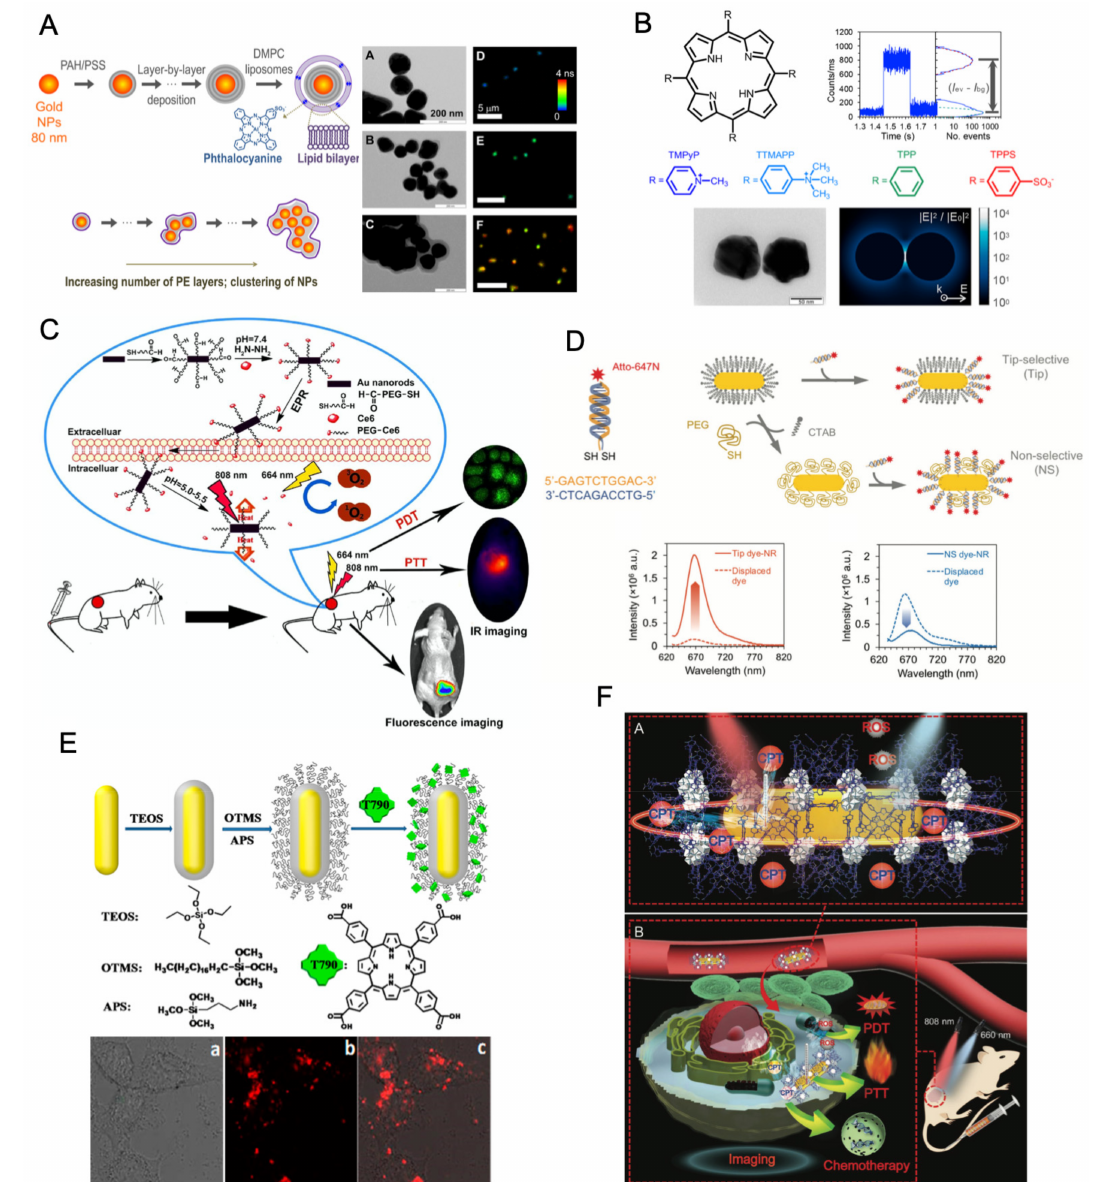
Figure 9. ( A ) Sequence of core-shell preparation of gold nanoparticles with a polyelectrolyte shell of PAH/PSS layers and an outer DMPC lipid bilayer embedding a phthalocyanine dye (top left). Gold nanoparticles form clusters as the number of polyelectrolyte layers is increased (bottom left). Electron microscopy (TEM) and fluorescence lifetime (FLIM) images of gold nanoparticles modified with a polyelectrolyte shell for an increasing number of PAH/PSS layers (5, 9, and 21 layers from the top down). Adapted with permission from [155]. Copyright 2015 American Chemical Society. ( B ) Chemical structure of the four porphyrins investigated for plasmon-enhanced fluorescence. Intensity time trace (top left) and example of an event of extreme fluorescence enhancement for TMPyP porphyrin (top right). TEM images of a dimer of gold nanoparticles obtained by DNA-directed assembly and near-field enhancement map calculated from discrete dipole approximation simulations. Adapted with permission from [156]. Copyright 2019 American Chemical Society. ( C ) Synthesis of core-shell hybrid gold nanorods Ce6-PEG-AuNR and their function for combined PTT/PDT [157]. © 2017 Elsevier B.V. All rights reserved. ( D ) Scheme of dye-labelled dsDNA oligonucleotide and preparation of dye-particle nano-assemblies using: (top) tip-selective thiol attachment toward the nanorod tips; (bottom) non-selective coating process with thiolated